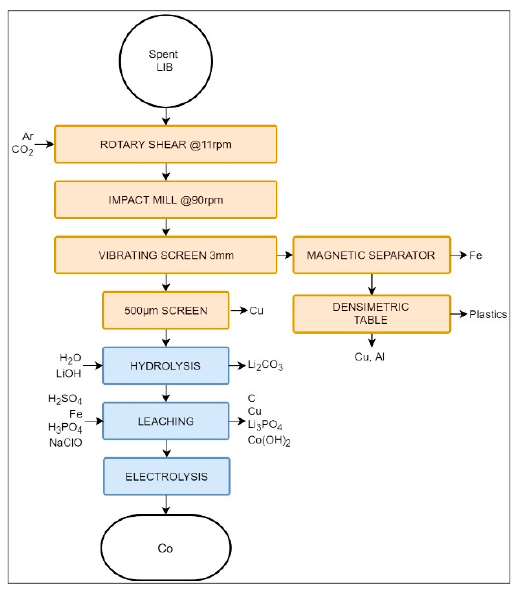
Figure 4. Schematic representation of the Recupyl Valibat recycling process.